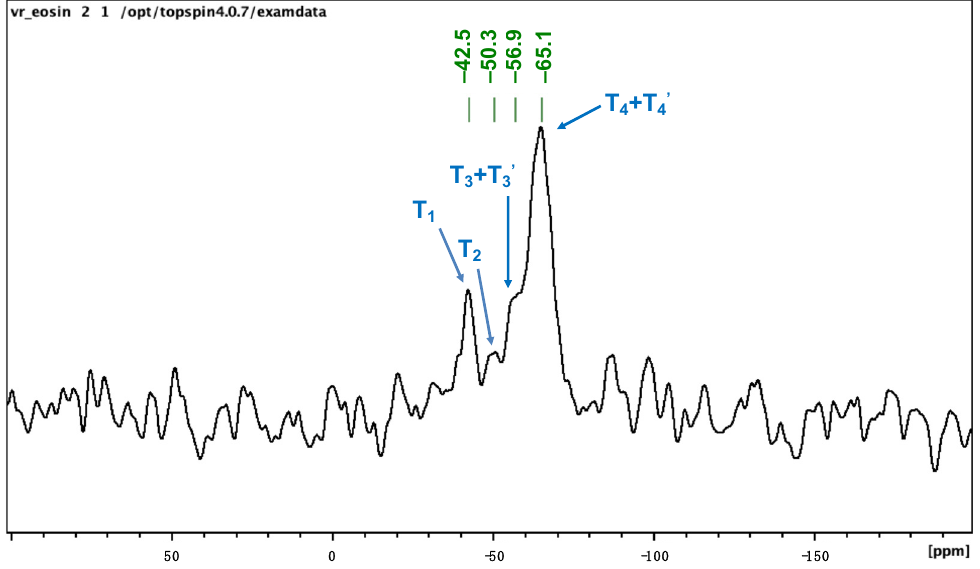
Figure 2. 29 Si CP-MAS NMR spectrum of EY-APTES@PDA@PUF. Low magnification SEM images of EY-APTES@PDA@PUF did not reveal obvious